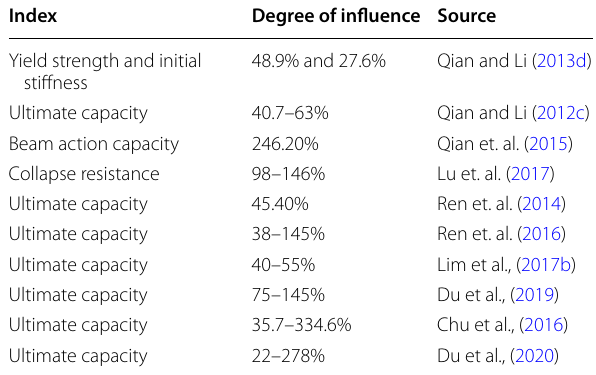
Table 1 Summary of quantified influence by slabs in experimental